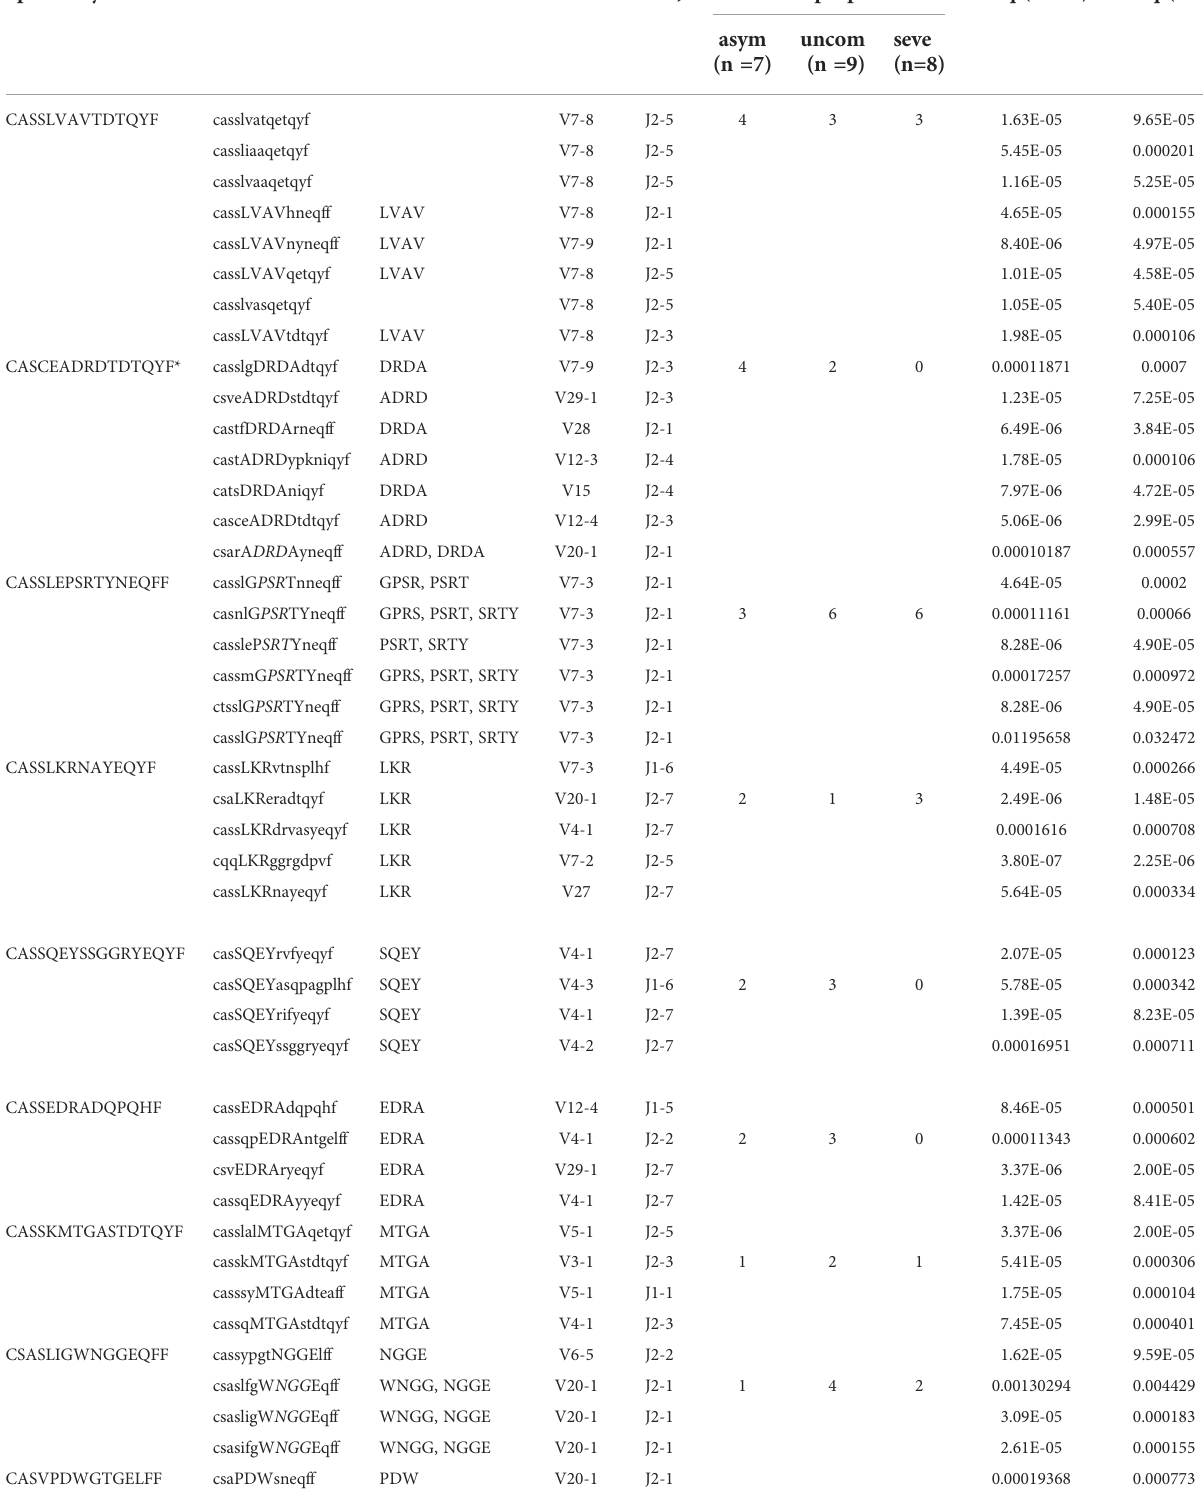
TABLE 3 TCR speci fi city clusters observed in the P. falciparum- infected cohort. Speci fi city